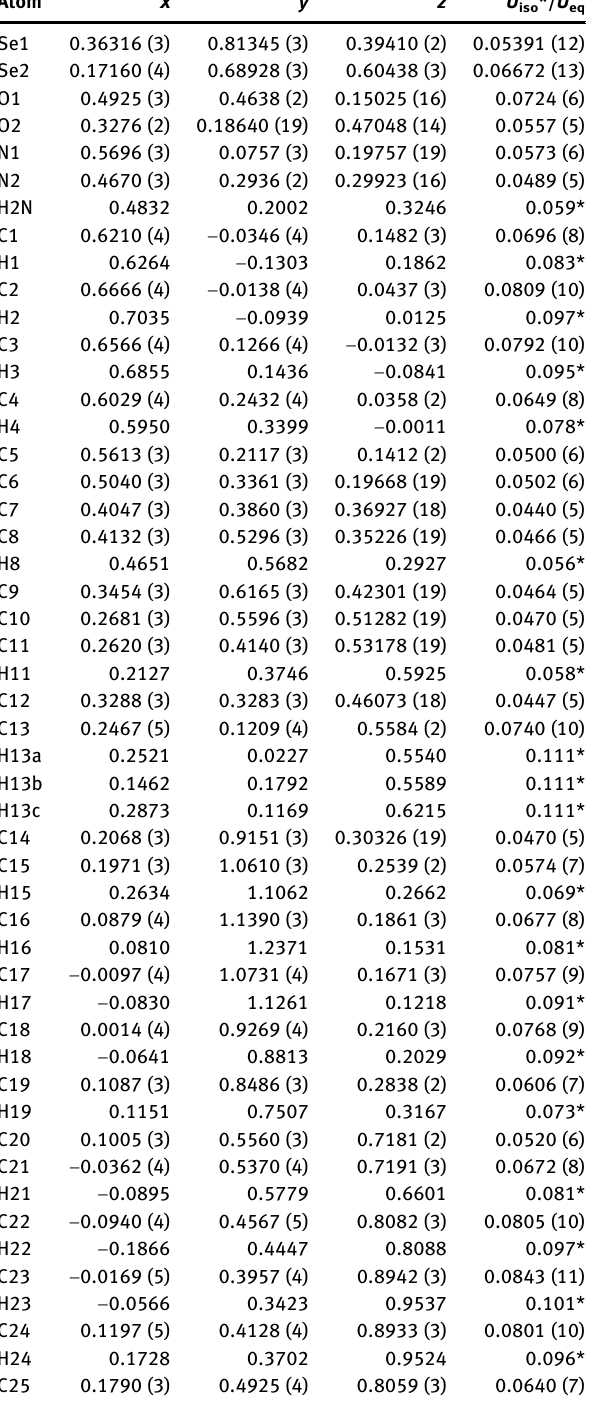
Various diaryl selenides have shown good antiprolifera- tion, antimicrobial, antiinflammatory, antihypertensive,